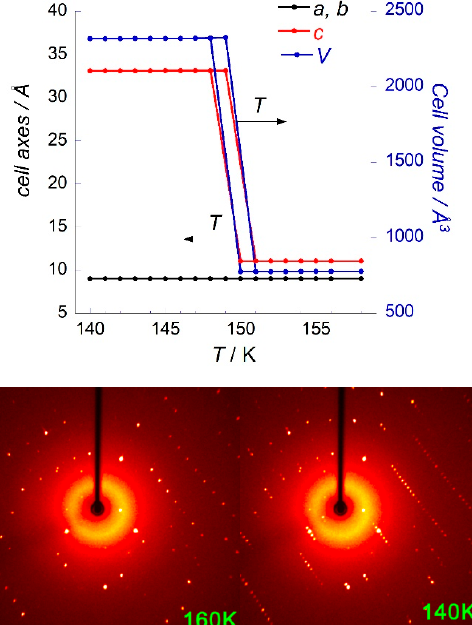
Figure 4. (top) Cell axes and volume as a function of temperature measured by X-ray diffraction between 158 and 140 K on a single crystal of [Mn(en) 3 ](NO 3 ) 2 ; (bottom) Diffraction images of [ Λ -Mn(en) 3 ](NO 3 ) 2 at 160 and 140 K (see supplementary information).